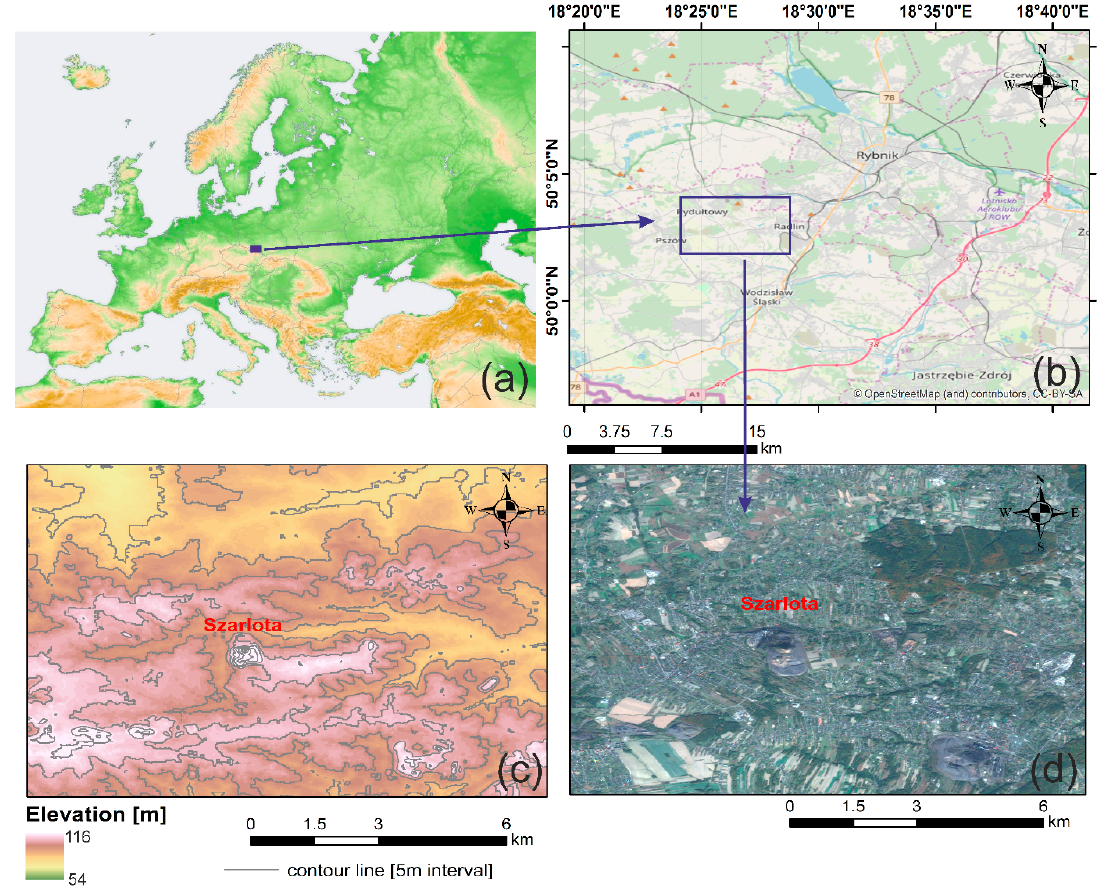
Figure 1. Location of the study area on the Europe map ( a ) and Open Street map ( b ). The bottom images represent the shaded DEM ( c ) and RGB true color composition from Sentinel 2B acquired on 15 October 2018 ( d ).